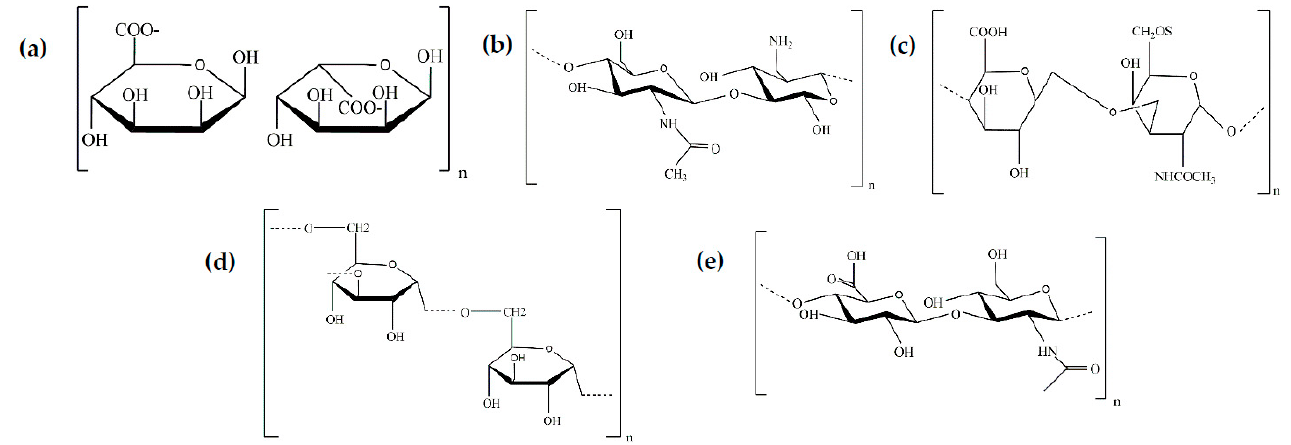
Figure 4. Monomeric unit of polysaccharides. ( a ) Alginate. ( b ) Chitosan. ( c ) Chondroitin sulfate-C. ( d ) Dextran. ( e ) Hyaluronic acid.